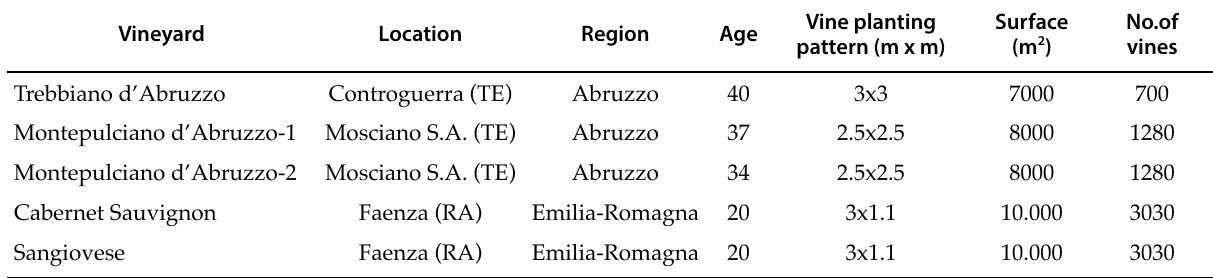
2 , Mg(NO 3 ) 2 and seaweed extract in 2013–2015.